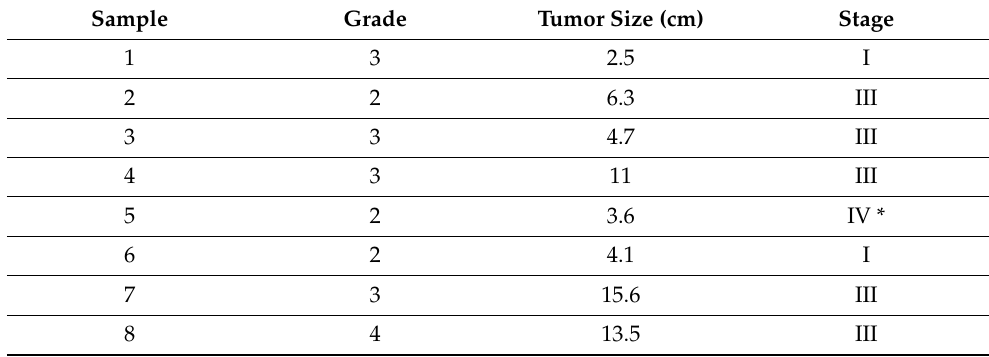
Figure 2. Baseline mRNA expression in patient-derived ccRCC cell cultures. Patient-derived ccRCC cells have increased ( A ) HIF2A , ( B ) CD70 , ( C ) SLC2A1 , ( D ) CCND1 , ( E ) VEGFA , ( F ) CXCR4 , ( G ) CXCL12 mRNA expression compared to HK-2 kidney epithelial cells. N = 8. * p < 0.05, ** p < Table 1. ccRCC patient Table 1. ccRCC patient characteristics.